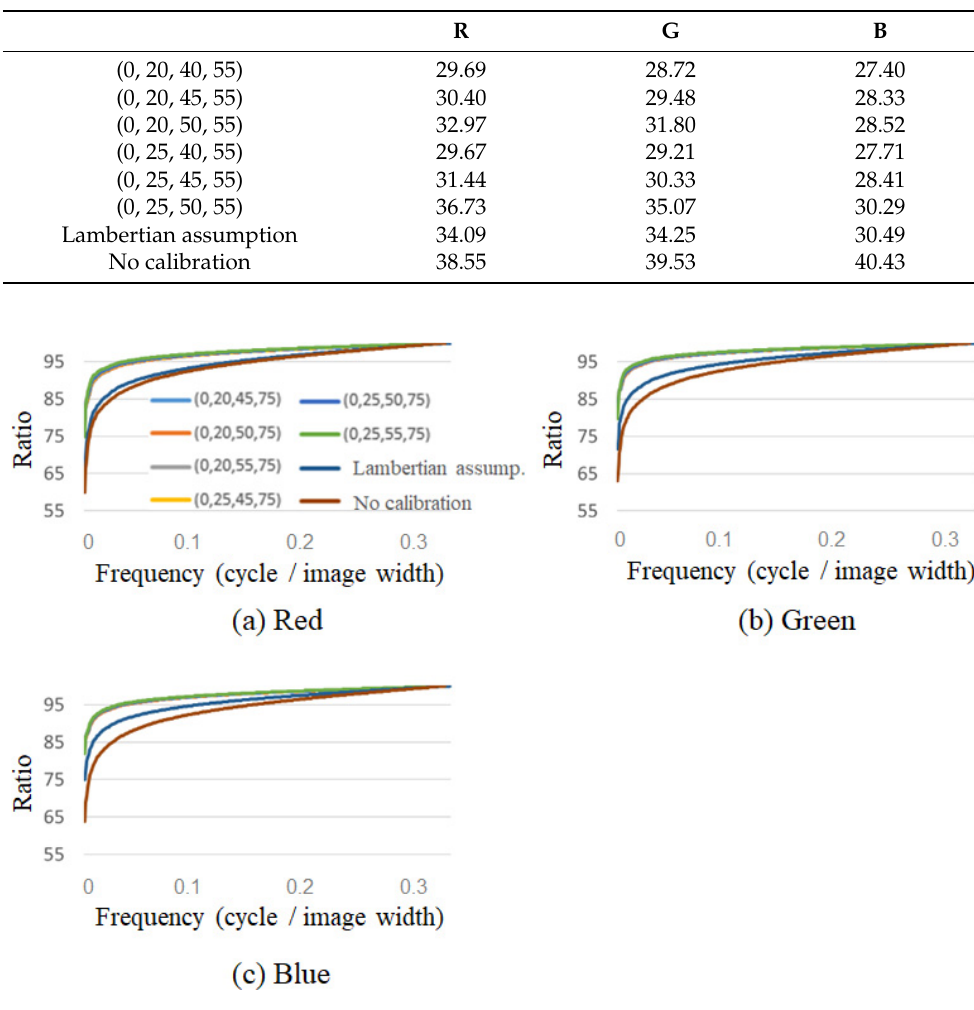
Figure 8. Frequency analysis of captured RGB values on the horizontal line indicated in Figure 6 (green projection onto encapsulated lens type).